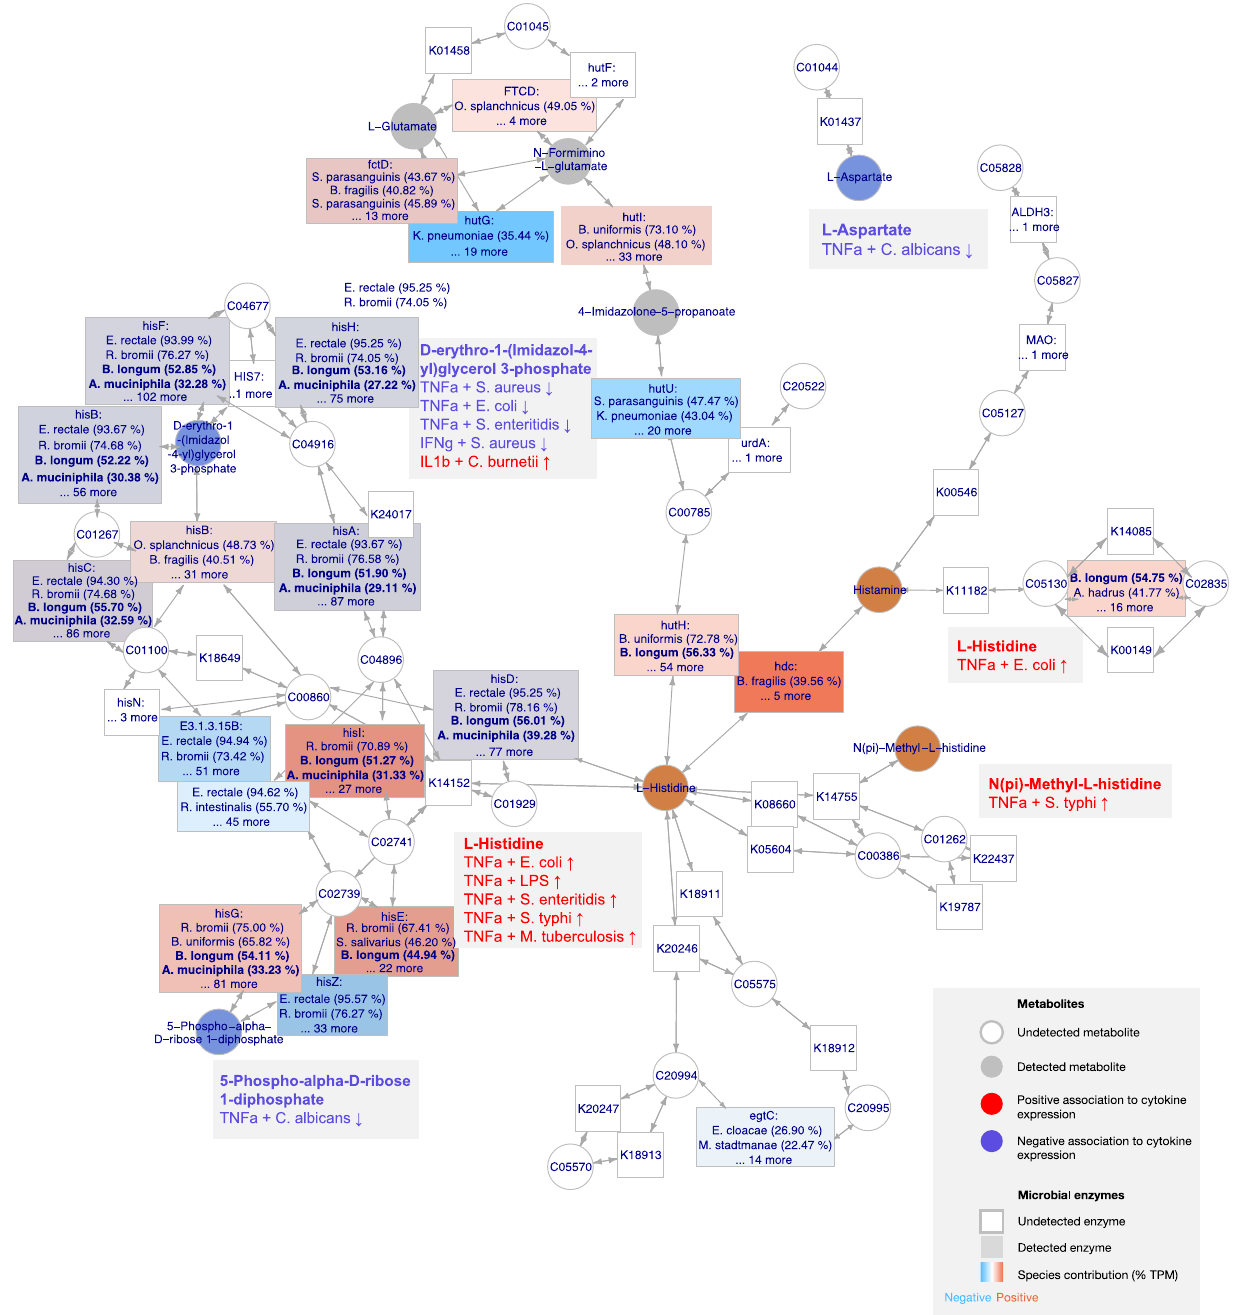
Fig. 6 Detected enzymes, metabolites, and associations in the histidine metabolism pathway (KEGG KO00340). Colored nodes represent detected microbial enzymes (squares) and compounds (circles), with signi fi cant correlations with cytokine responses in red (positive) and blue (negative). Enzymes detected in stool microbiomes are shown as colored squares, with contribution from negative (blue) or positive species (red) quanti fi ed as a fraction of total RPKM in the cohort per species type. Percentages in squares show prevalence of enzyme encoded by each species. Source data are provided in the Source data fi